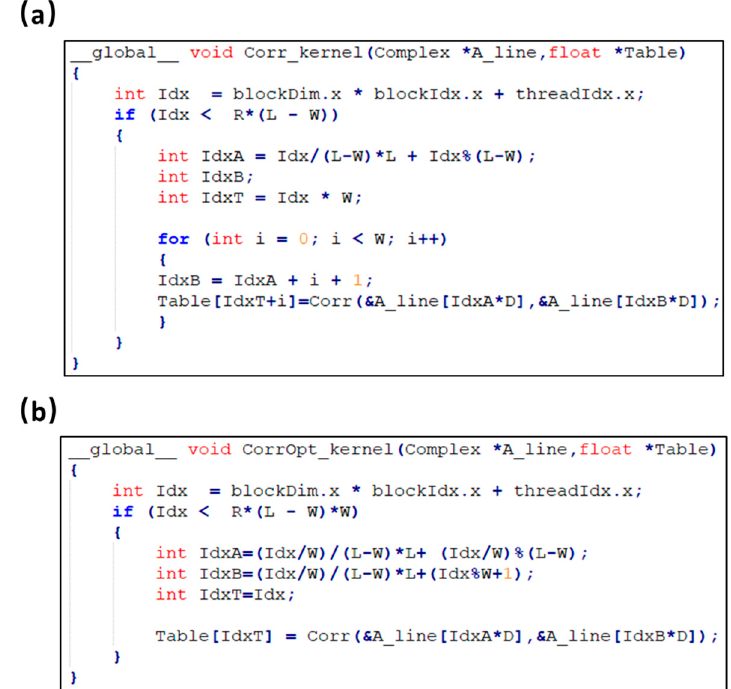
Figure 9. Kernel function of correlation calculation with CUDA. (a) Initial implementation. (b) Optimized implementation. Idx, thread address index; IdxA and IdxB, the input data addresses for A-line pair; IdxT, the output data address for the correlation coefficient table.